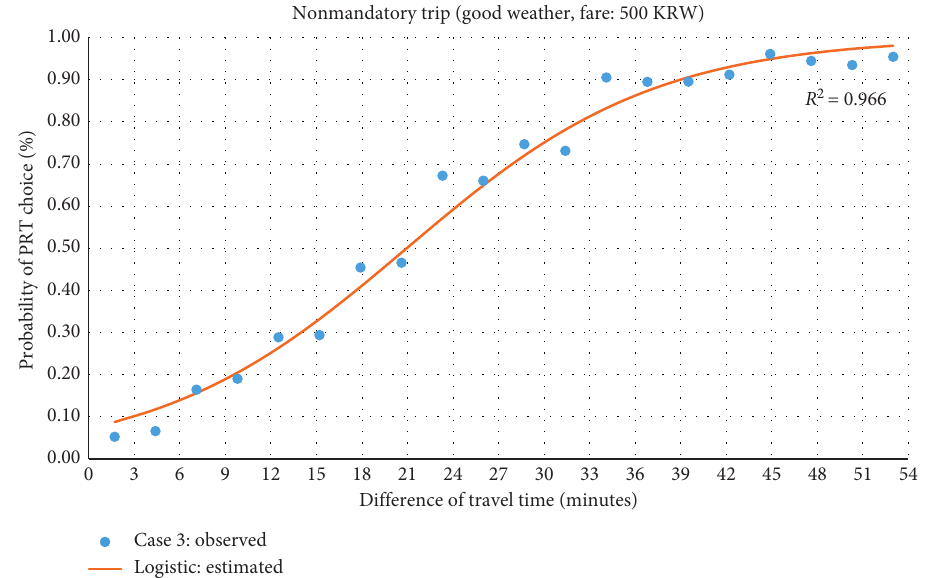
Figure 12: Logistic regression curve of the nonmandatory trip with 500 KRW under good weather (scenario